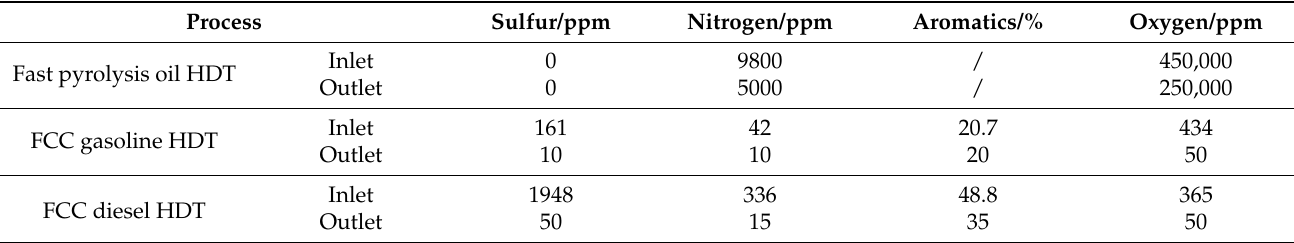
Table 7. Impurity contents of inlet and outlet streams in HDT processes